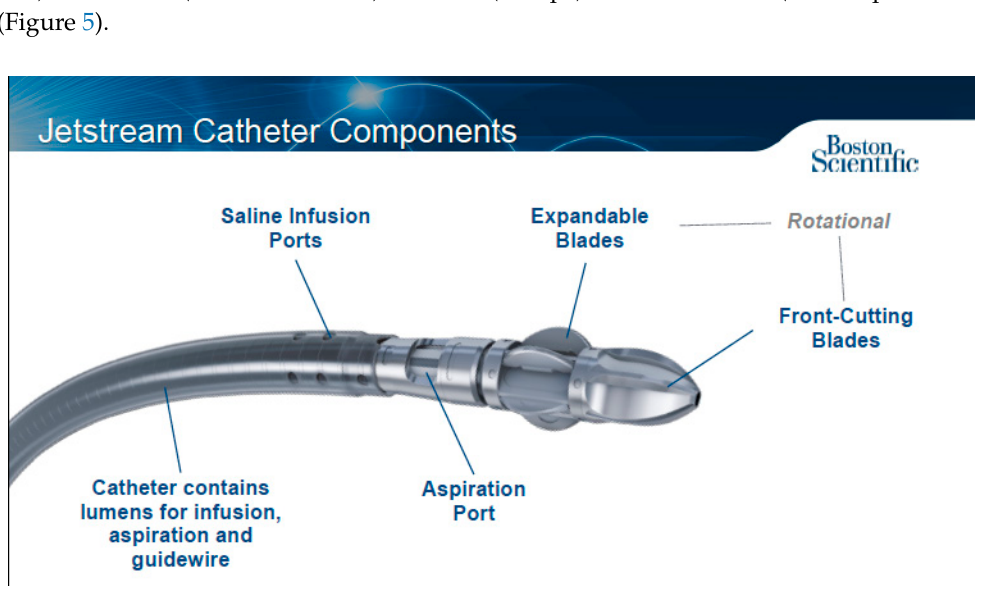
Figure 4. Jetstream Atherectomy System. Courtesy Boston Scientific Corporation. J. Clin. Med. 2020 , 9 , x FOR PEER REVIEW